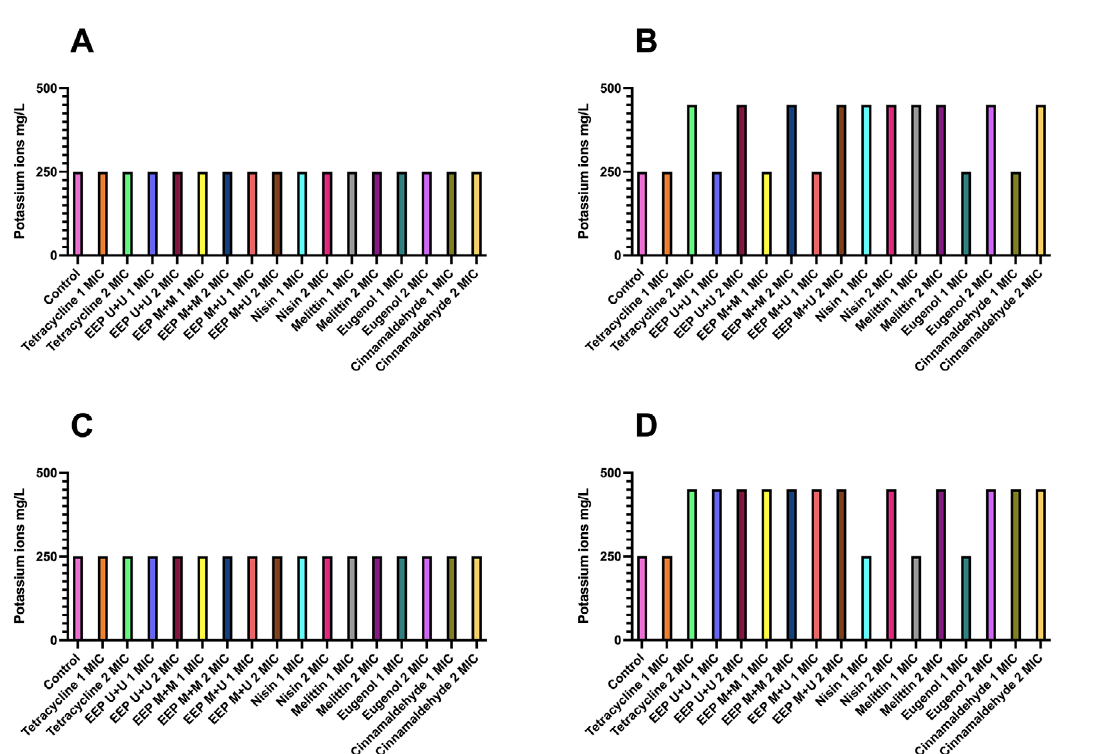
Figure 3. Release of potassium ions from B. subtilis at times (A) T0 and (B) T4 and P. alvei at times (C) T0 and (D) T4 after treatment with tested products at concentrations of 1 and 2